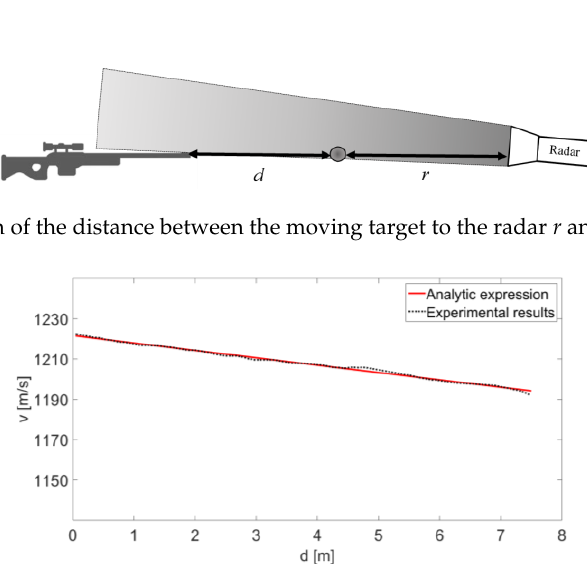
Figure 10. Instantaneous velocity of a small object as dependent on d .